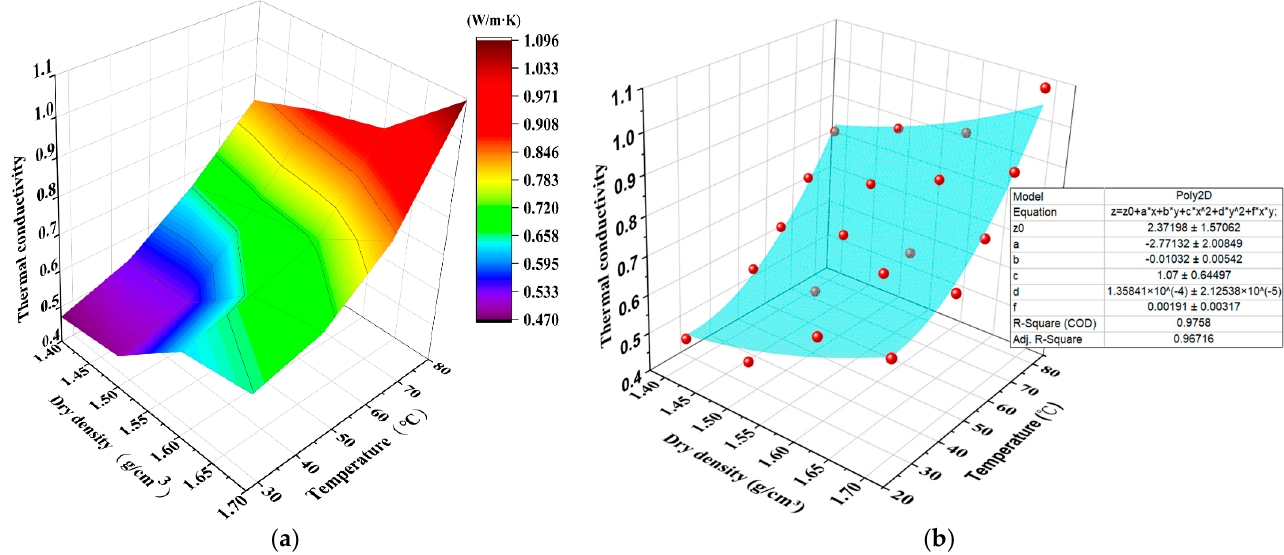
Figure 14. Thermal conductivity ( λ -D-T): ( a ) 3-D representation; ( b ) 3-D non-linear surface fit.